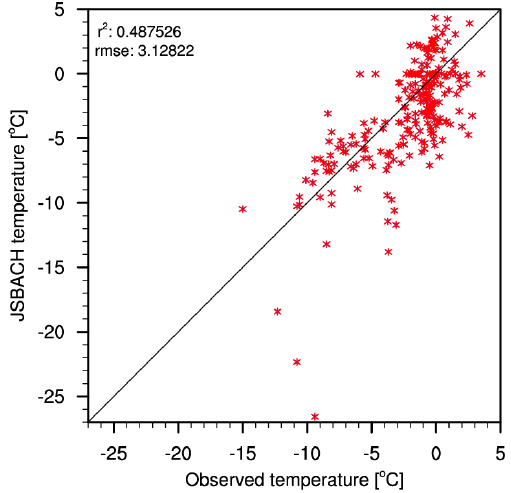
Fig. 10. Scatter plot of observed soil temperature from the GTN-P borehole temperature data set (Romanovsky et al., 2010b) versus simulated subsoil temperature (deepest soil layer, ca. 7m). See text for further